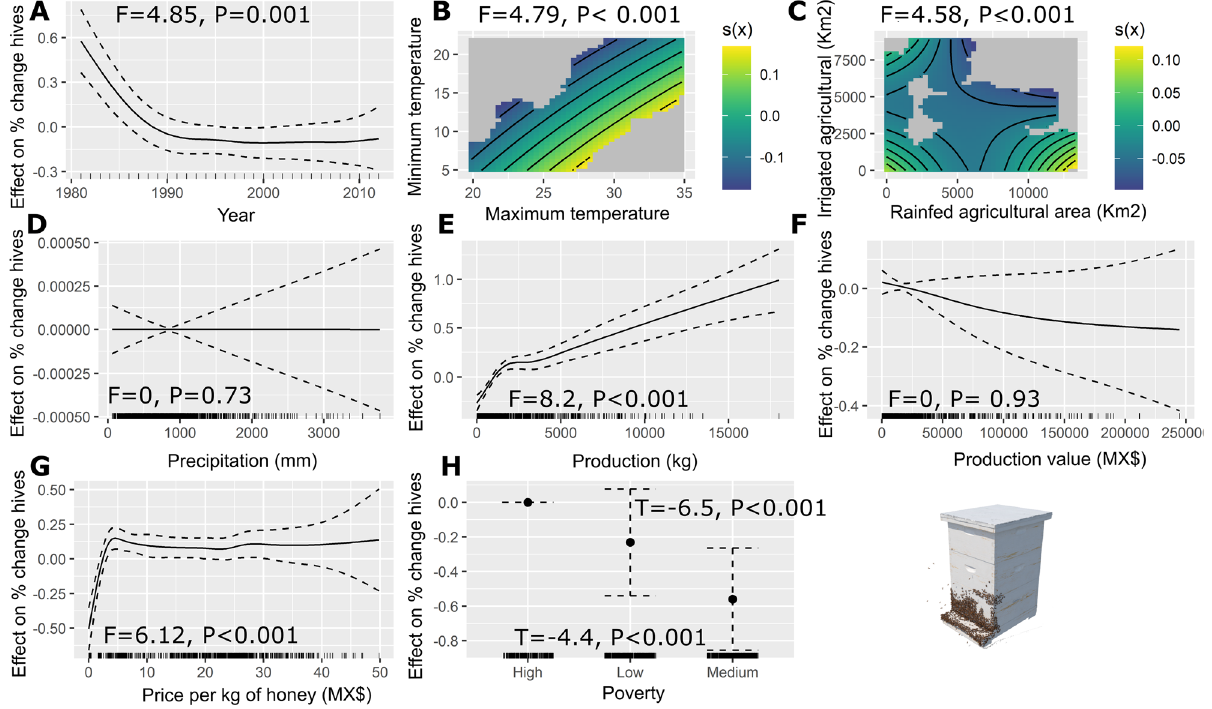
Figure 1. Estimated smoothness of; ( a ) year, ( b ) non-linear interaction between minimum temperature and maximum temperature, ( c ) non-linear interaction between land use categories, ( d ) precipitation (mm), ( e ) production of honey (kg), ( f ) production value (MX$), ( g ) price per kg of honey (MX$), and ( h ) poverty over the percent change in honey bee hives; y-axis is the partial effect of the variable and the shaded area represents 95% of the confidence interval around the main